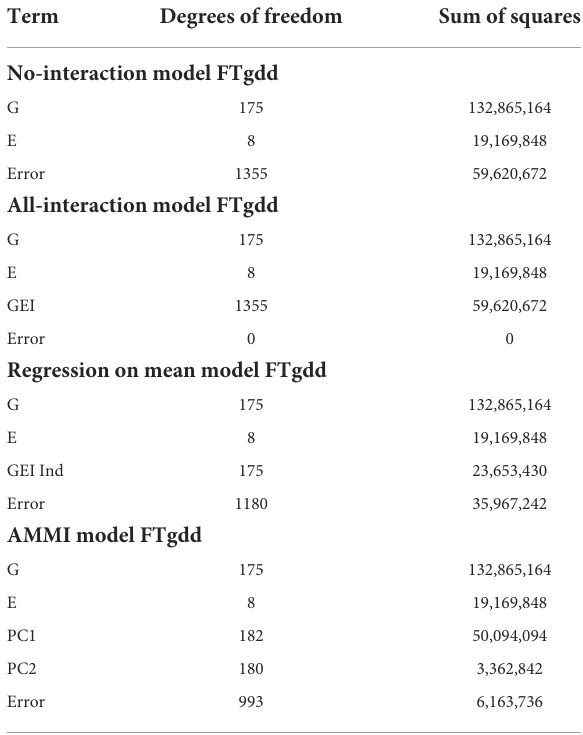
TABLE 7 Biclustering results with the smallest SSE values obtained from fitting no-interaction models on each bicluster for raw responses (30 trials—rice data FTgdd).